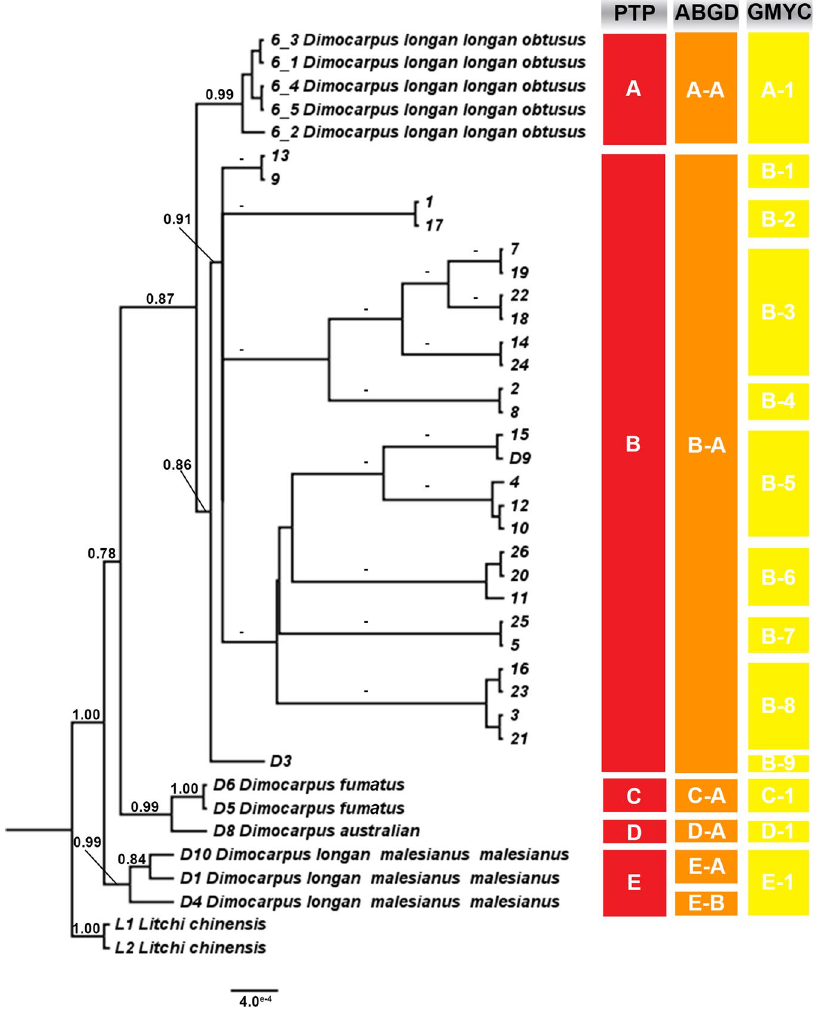
Figure 4. Species delimitation analyses on the concatenated dataset. The tree of species delimitation analyses was reconstructed using Poisson Tree Processes (PTP), Automatic Barcode Gap Discovery (ABGD), and General Mixed Yule Coalescent (GMYC) and was labeled with Bayesian (posterior probability, P; top) support values for each node on this Bayesian phylogenetic